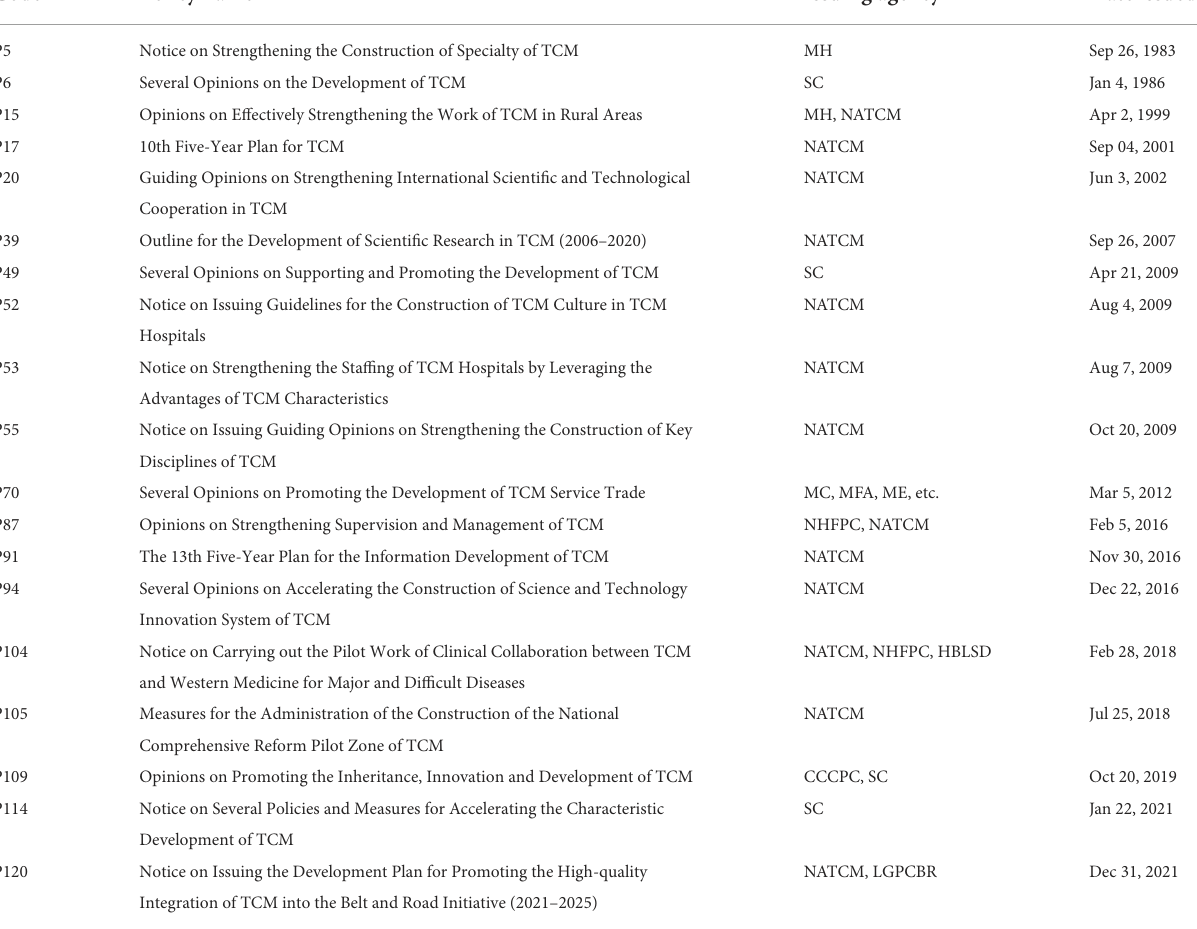
TABLE 1 The selected TCMDPs in this study.